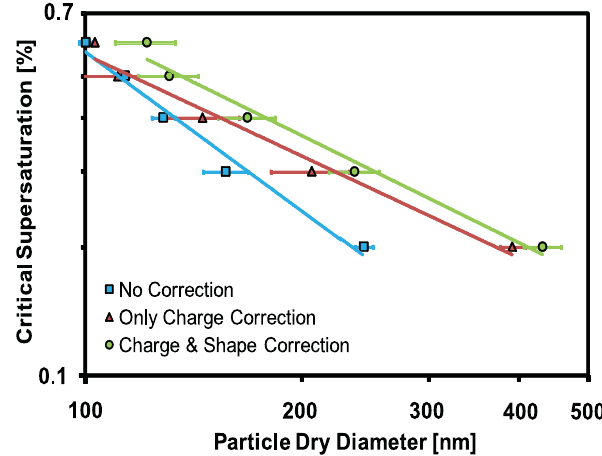
Fig. 4. CCN activation curves ( s c - D dry ) for ATD ( χ = 1 . 3 ± 0 . 2) showing the effect of including charge and shape corrections on the raw data. Blue shows curve with no correction, brown shows the results with charging corrections and green shows curve after in- cluding both charge and shape corrections. Error bars represent ex- perimental uncertainty and numerical uncertainty in D dry at same instrument